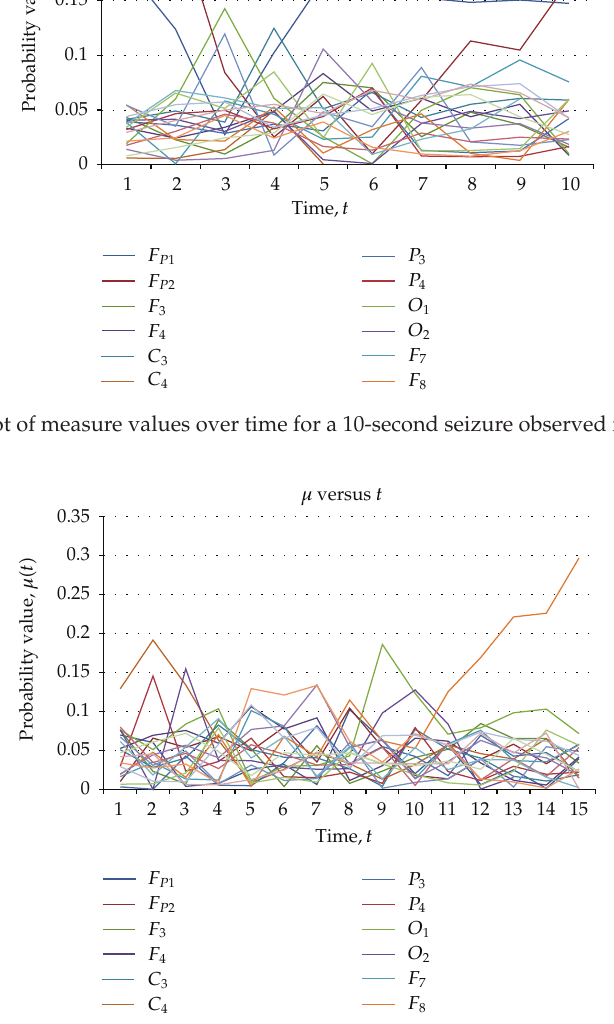
Figure 6: Plot of measure values over time for a 15-second seizure observed in Patient